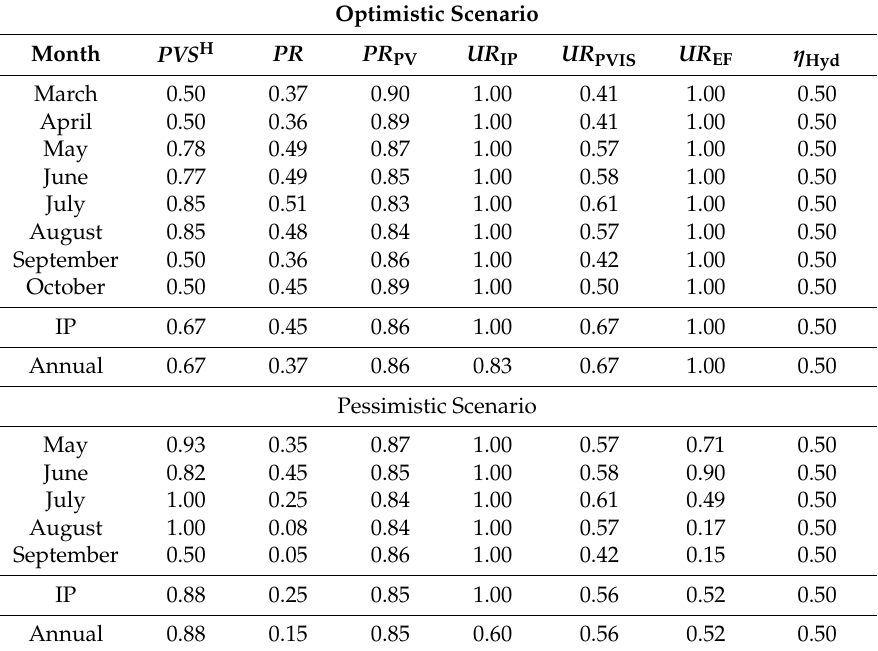
Table 4. Simulated performance indices for the optimistic and pessimist scenarios.